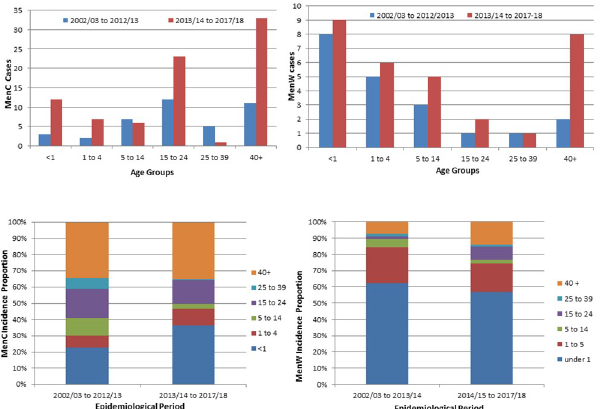
Fig 2. Actual numbers and proportions of both MenC and MenW disease incidence, by age group and over the epidemiological periods 2002/03 to 2012/13 and 2013/14 to 2017/18. The number of cases of MenC and MenW disease are shown in the top row, and age specific proportions of MenW and MenC incidence is shown in the bottom row.